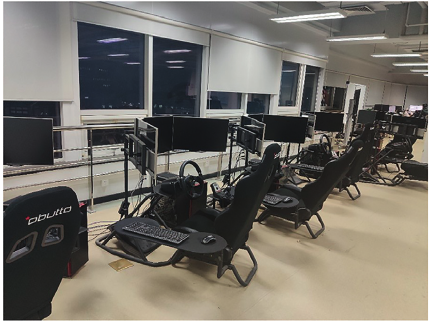
Figure 1: The Multiuser Driving